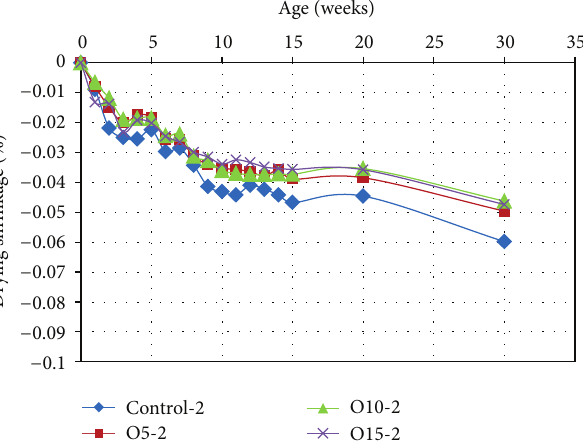
Figure 6: Drying shrinkage of geopolymer mortar containing 5% OPA.